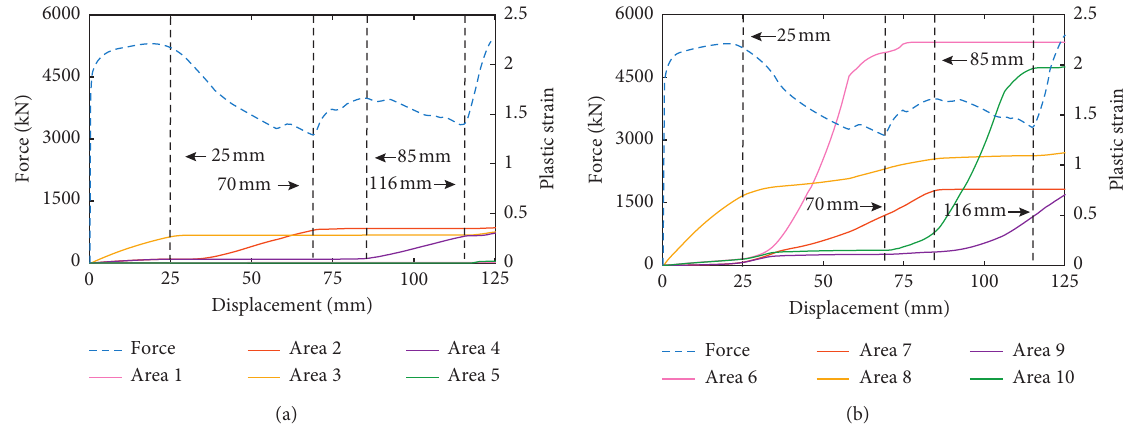
Figure 7: Load and plastic strain curve of each area of the device: (a) concave side wall; (b) convex side wall.